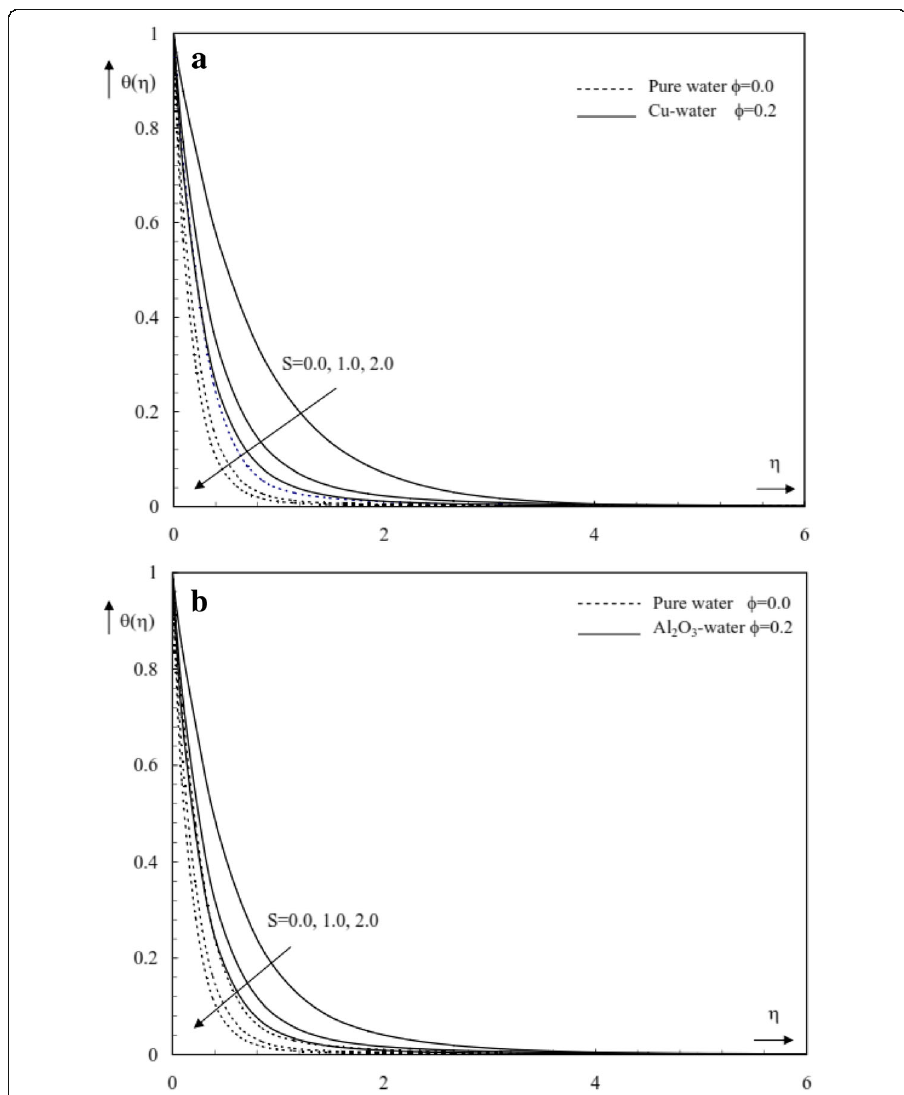
Fig. 16 Effects of ϕ and S on velocity distribution θ ( η ) for f w = M = 0.1 and A = B = λ = 0.5 for a Cu-water and b Al 2 O 3